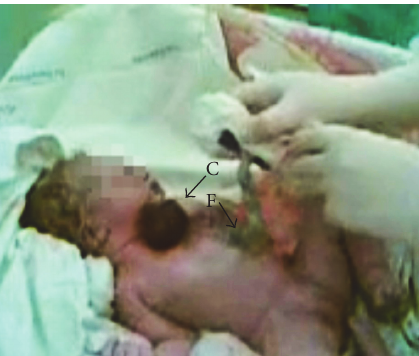
Figure 1: Ultrasound of fetus heart at 42nd week of gestation, thoracic cleft, and major blood vessels transposition. Ao: aorta, RV: right ventricle, and LV: left ventricle. A: wide anterior thoracic defect, B: ventricular septum, C: ectopic heart, and D: chest.